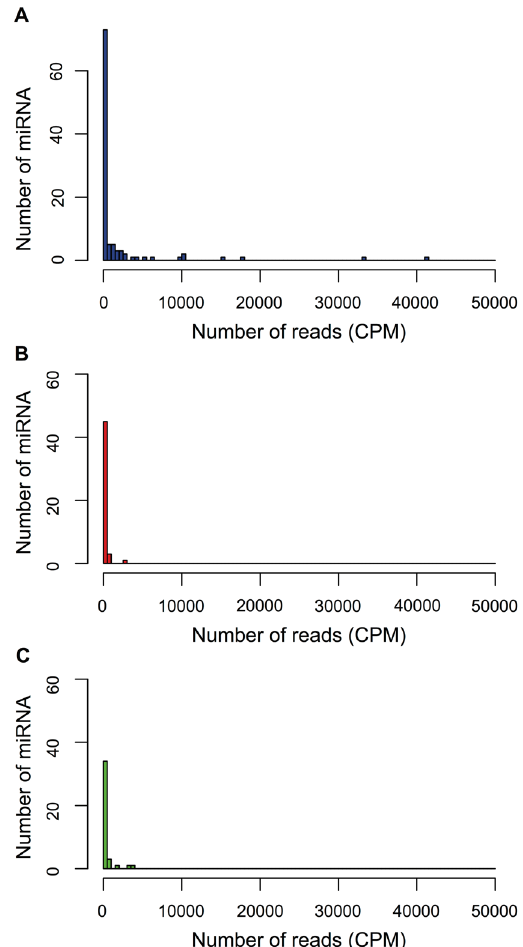
Figure 6. Distribution of miRNAs based on their average expression levels for C. reinhardtii ( A ) and for the species-specific miRNAs in Arabidopsis thaliana ( B ) and Arabidopsis lyrata ( C ). Binning was done with 500 CPM (Counts Per Million mapped reads)